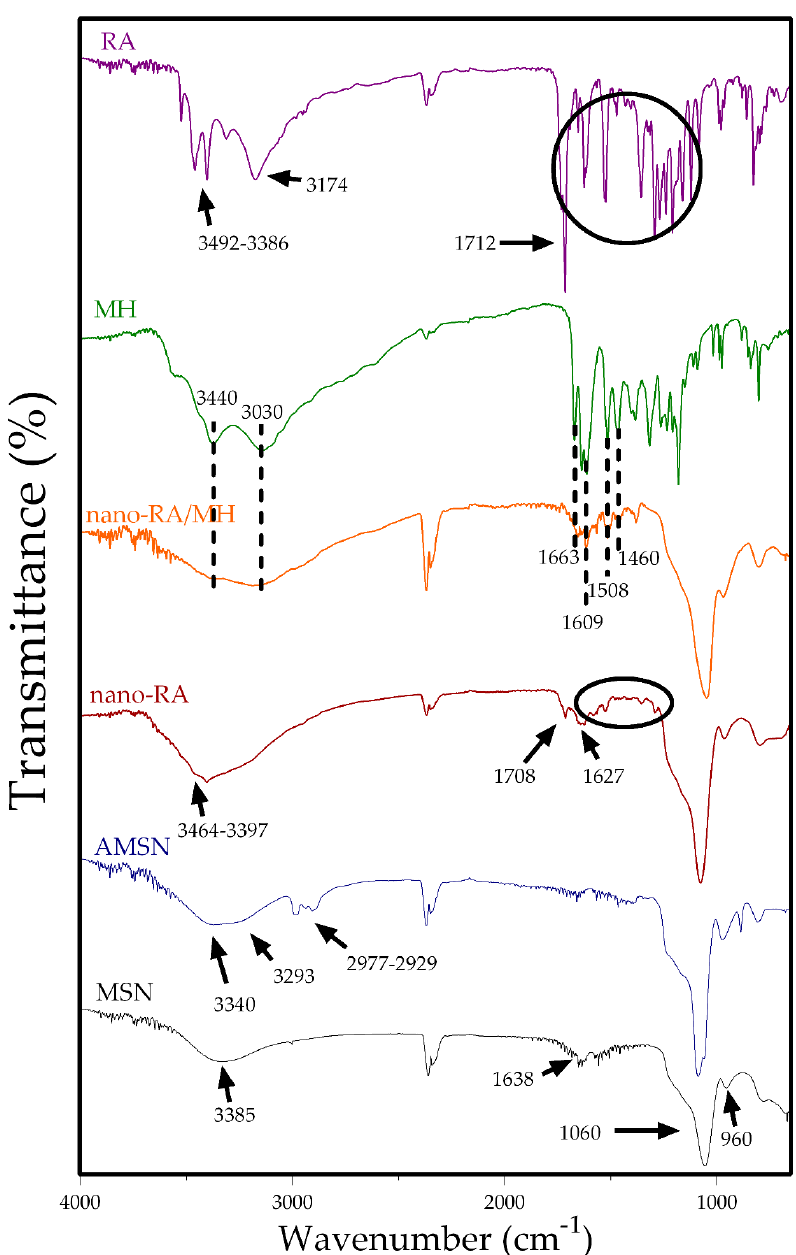
Figure 3. Fourier-transform infrared (FT-IR) spectra of MSN (black line), AMNS (blue line), nano-RA (red line), nano-RA/MH (orange line), MH (green line), and RA (purple line).